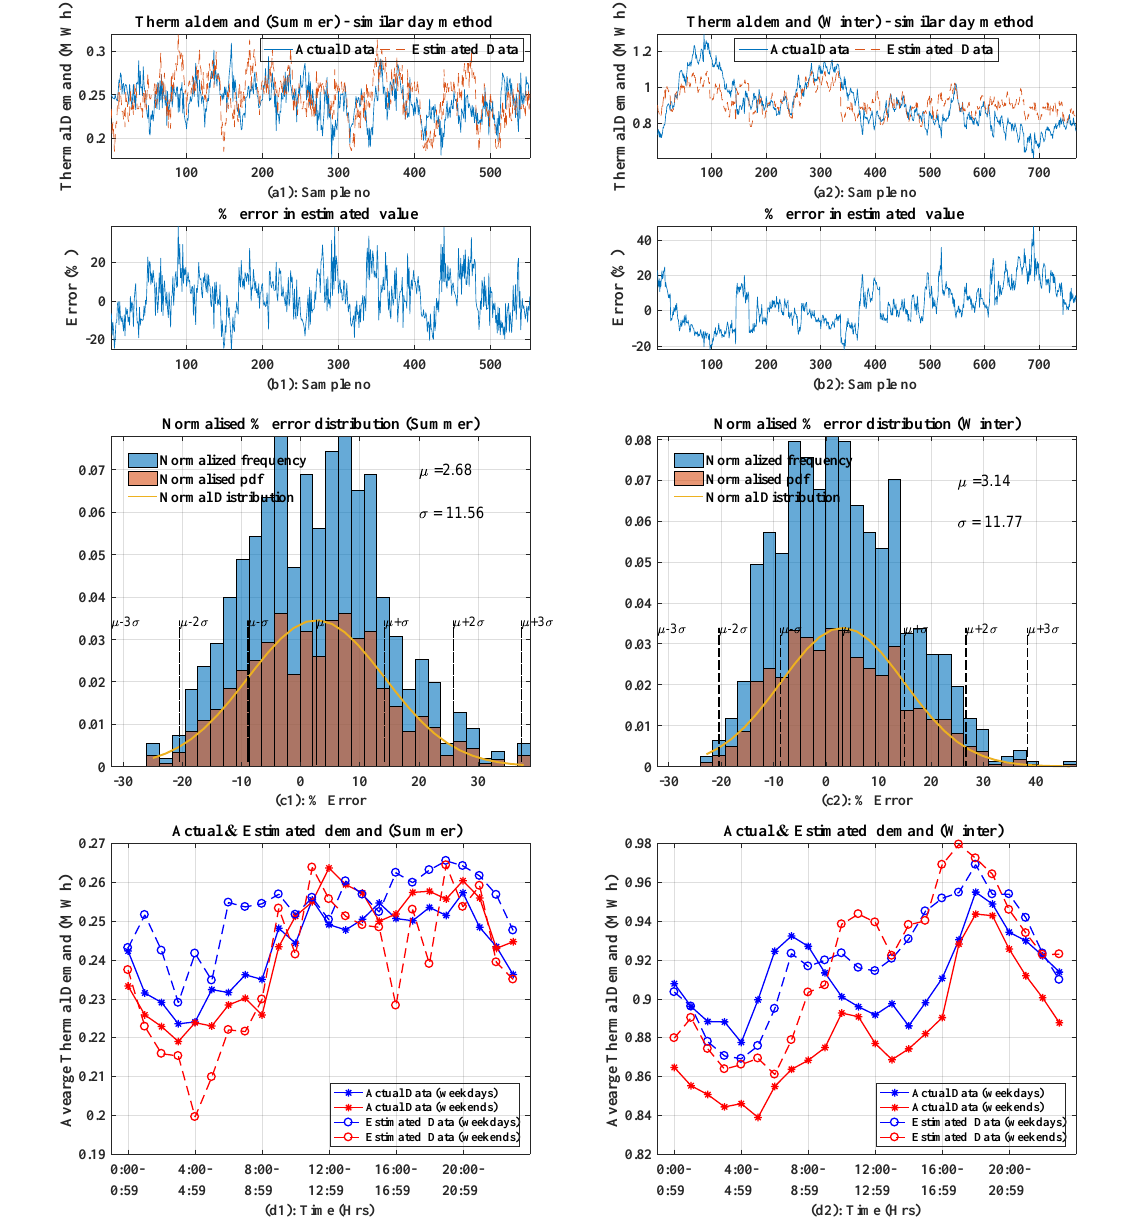
Figure 14. EStimation of thermal demand using similar day method for summer and winter. Row ( a ): actual data and estimated data. Row ( b ): % error associated with prediction of thermal demand. Row ( c ): histogram of %error and its normal distribution. Row ( d ): Analysis of average thermal demand (actual and estimated) in hourly basis for different weekdays and weekends. Table 4 summarises the results of different methods of estimation. Root mean square error (RMSE) is used to measure the difference between the estimated value by a model and the actual values observed. Mean absolute percentage error (MAPE) estimates how close estimated values are to actual values in